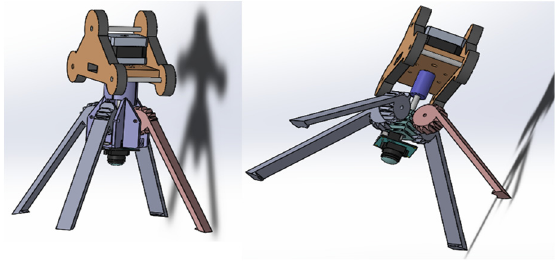
Figure 3. Design made in Solidworks for the gripper.